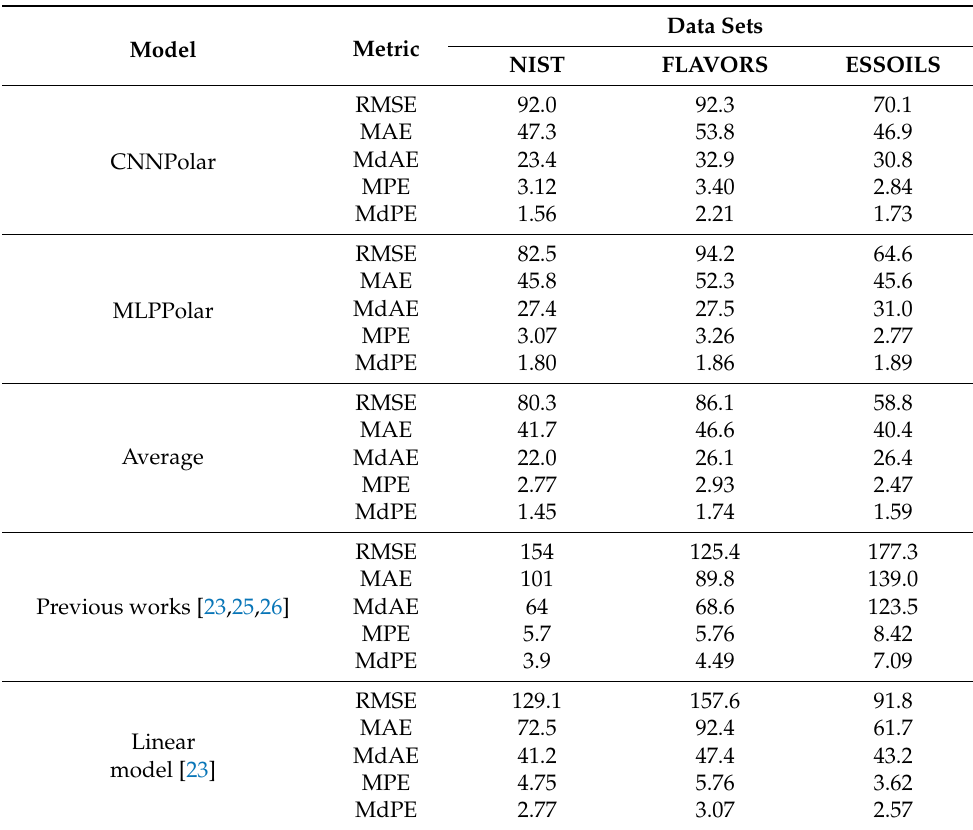
Table 2. The accuracy of retention index prediction for polar stationary